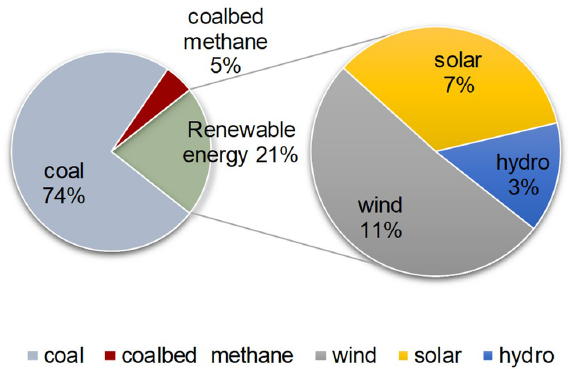
Figure 2. Distribution of electricity installed capacity in the Province of Shanxi in 2017.